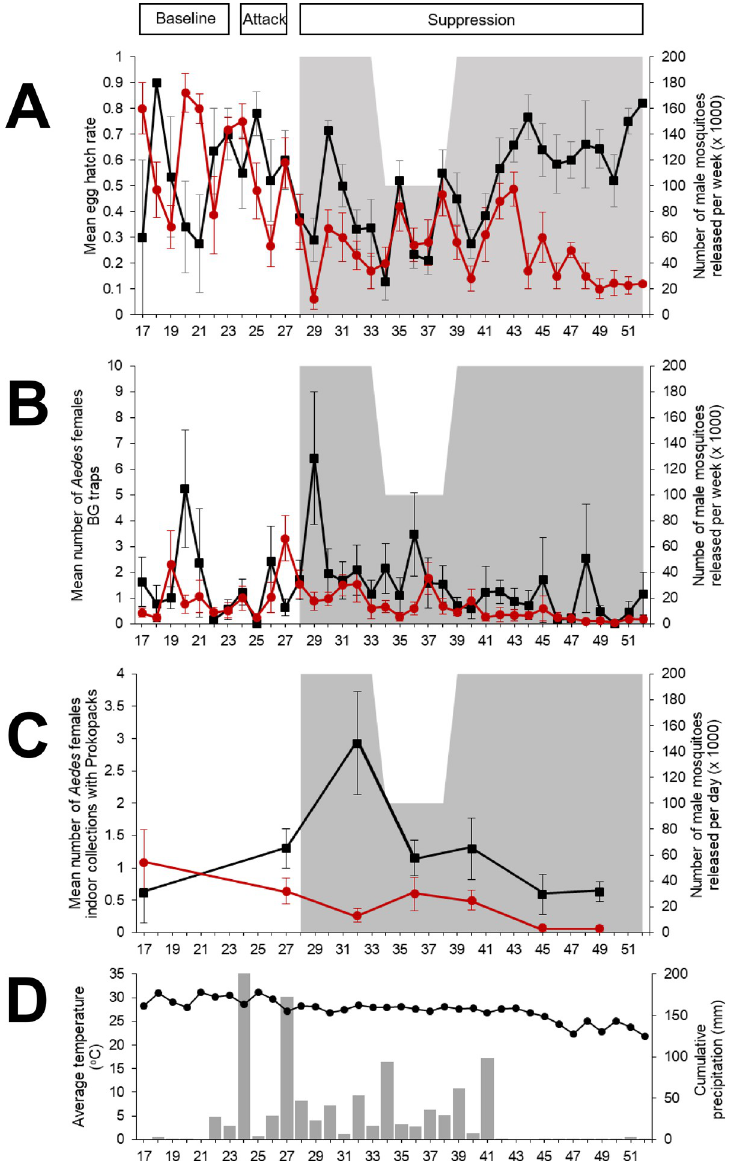
Fig 3. Entomological indicators of population suppression between release (San Pedro Chimay = red line) and control (Tahdzibiche´n = black line) sites. A) Mean hatching rate (SD) per week, B) Mean No. of females captured with BG traps (SD), C) Mean No. of indoor females captured with Prokopack aspirators, D) Average temperature and precipitation during the study period. Grey-shaded regions indicate release periods. The dashes in the X-axis represent the weeks of the